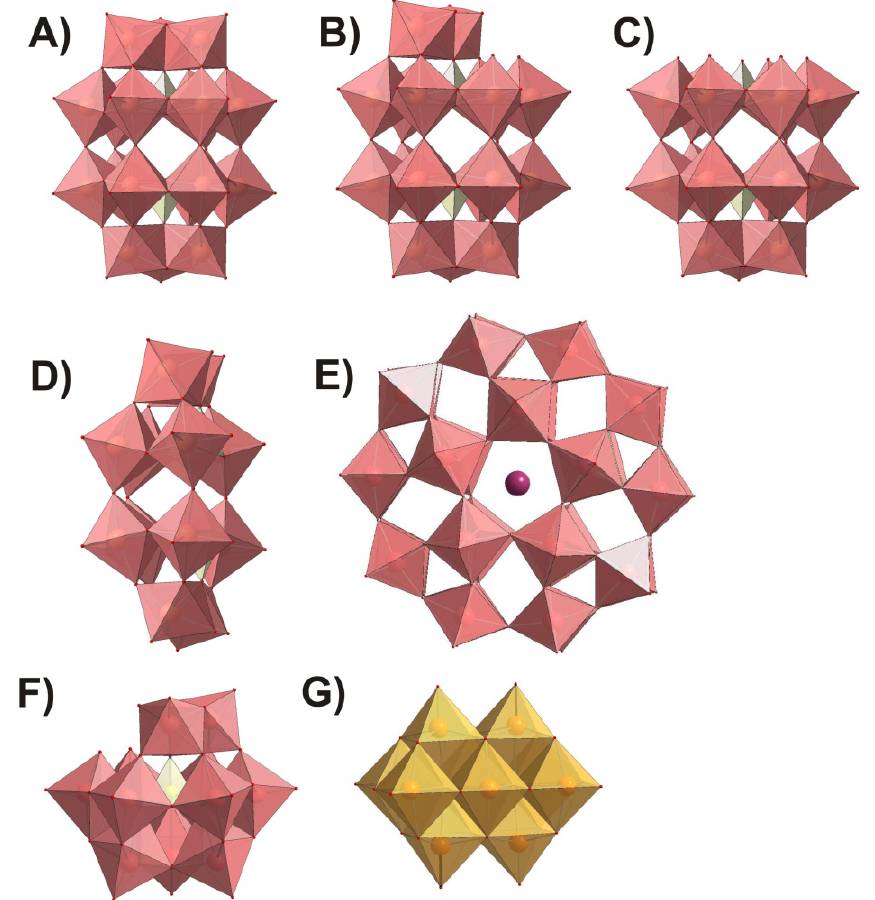
Figure 1. POM-type structures. ( A ) Wells–Dawson (P 2 W 18 ); ( B ) mono-lacunary Wells–Dawson (P 2 W 17 ); ( C ) tri-lacunary Wells–Dawson (P 2 W 15 ); ( D ) hexa-lacunary Wells–Dawson (P 2 W 12 ); ( E ) Preyssler (P 5 W 30 ); ( F ) mono-lacunary Keggin (MnV 11 ); ( G ) isopolyoxometalate (V 10 ). Color code ( A – F ): {WO 6 }, reddish; P, yellow; Na, red; ( F ) {VO 6 }, reddish; Mn, light yellow; ( G ) {VO 6 }, orange.